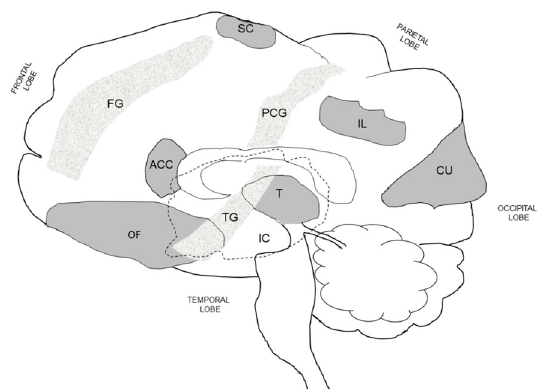
Figure 4. Idealistic drawing of human brain loci (dark shading) which have been associated with thirst, tongue movement, touching the tongue, swallowing, and taste (Tables 2, 4 and 5). Three ridges (gyri) on the cerebral cortex surface are shaded lightly. The dashed region represents the insular cortex (IC) which lies deep within the lateral surface of the brain. Brain loci abbreviations are defined in the Table 2 footnote.